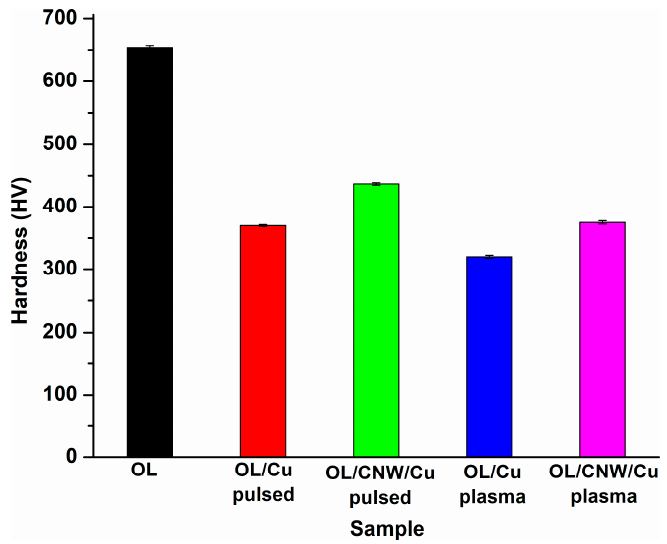
Figure 9. Vickers hardness for all coated samples.